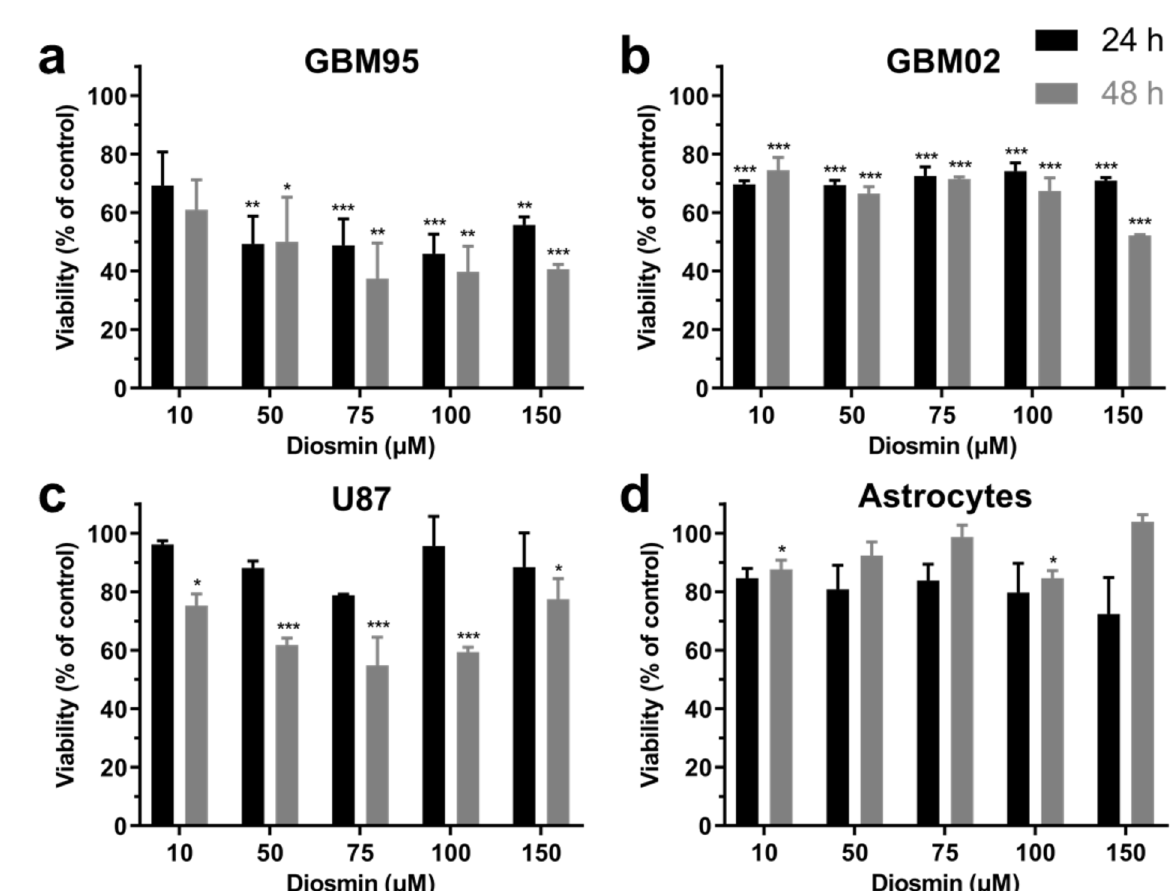
Figure 2 - diosmin reduced the viability of GBm95, GBm02, and U87mG cells, but did not reduce the viability of human astrocytes. Cell viability was assessed by mTT reduction assay and expressed as percentage of viable cells, compared to control (DMSO residue). Glioblastoma cells and healthy human astrocytes were treated with diosmin for 24 and 48 hours at different concentrations (10 to 150 μM). Representative graphs of the viability of GBM95 ( a ), GBm02 ( b ), U87mG ( c ), and healthy human astrocytes ( d ). Significant viability reduction was observed in glioblastoma cells under almost all conditions. Results represent the mean ± Sem of three independent experiments, each performed in triplicate (*p <0.05; **p <0.01; ***p